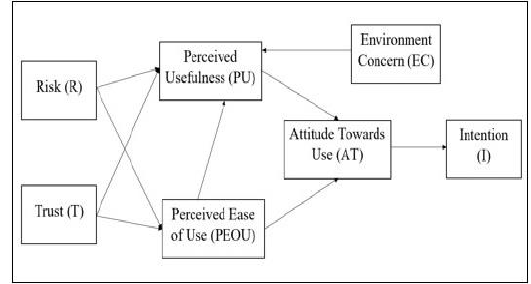
Figure 5. Conceptual